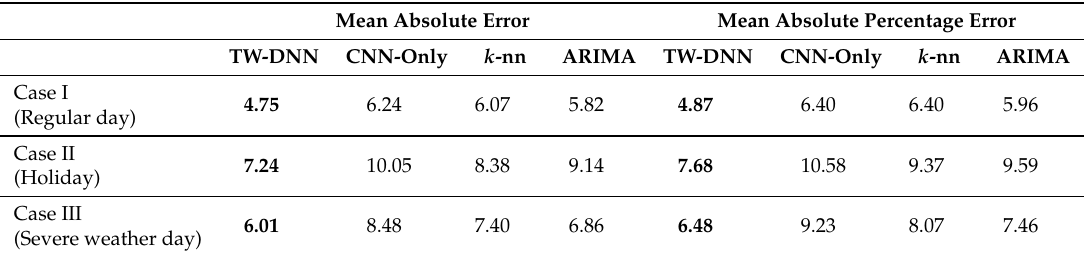
Table 2. Average mean absolute error and mean absolute percentage error of the test